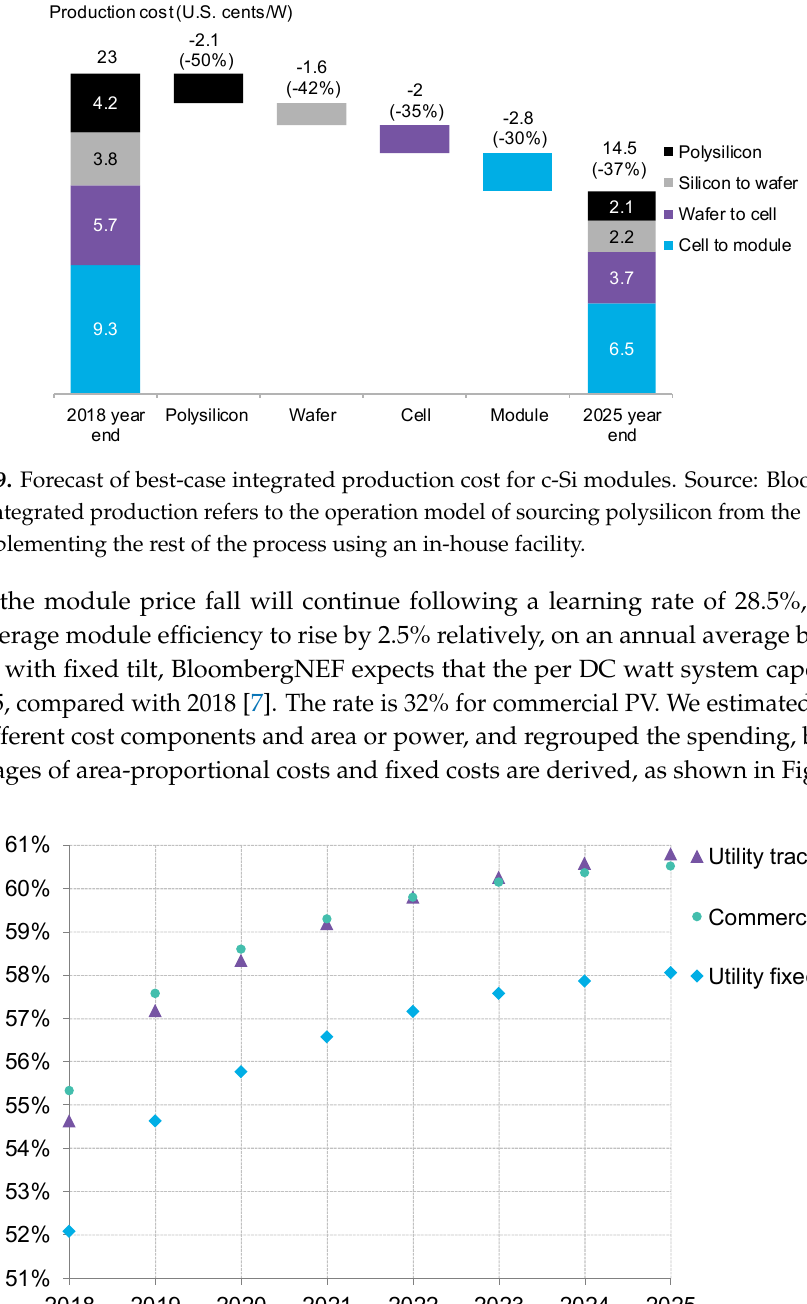
Figure 10. Estimated percentage of area-proportional and fixed non-module costs in PV capex.